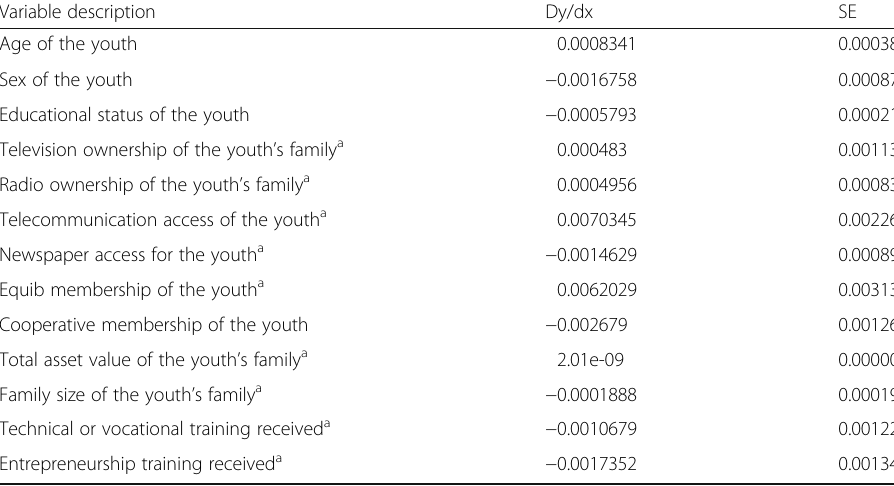
Table 11 Marginal effect for covariates of